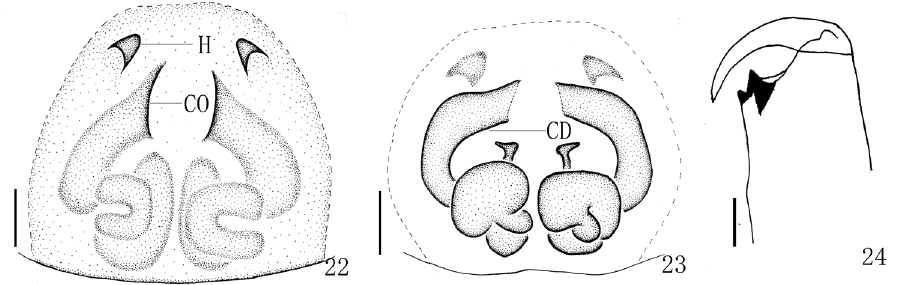
Figures 22–24. Yaginumaella pseudoflexa sp. n. 22 epigynum, ventral view 23 vulva, dorsal view 24 left chelicerae, posterior view. Scale bars: 0.1